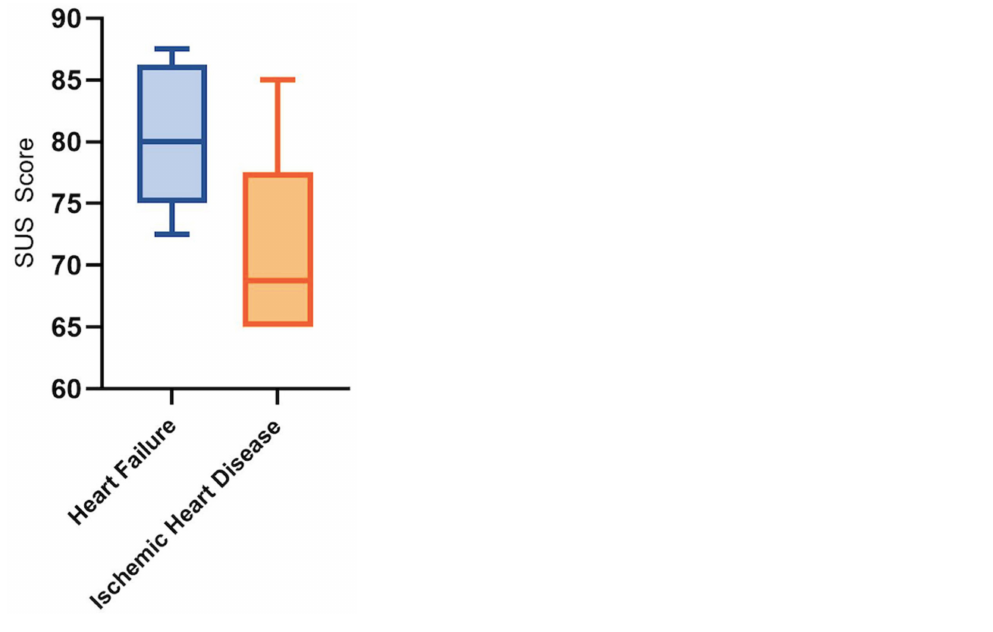
Figure 4. Preliminary results of the System Usability Survey in HF and IHD patients.